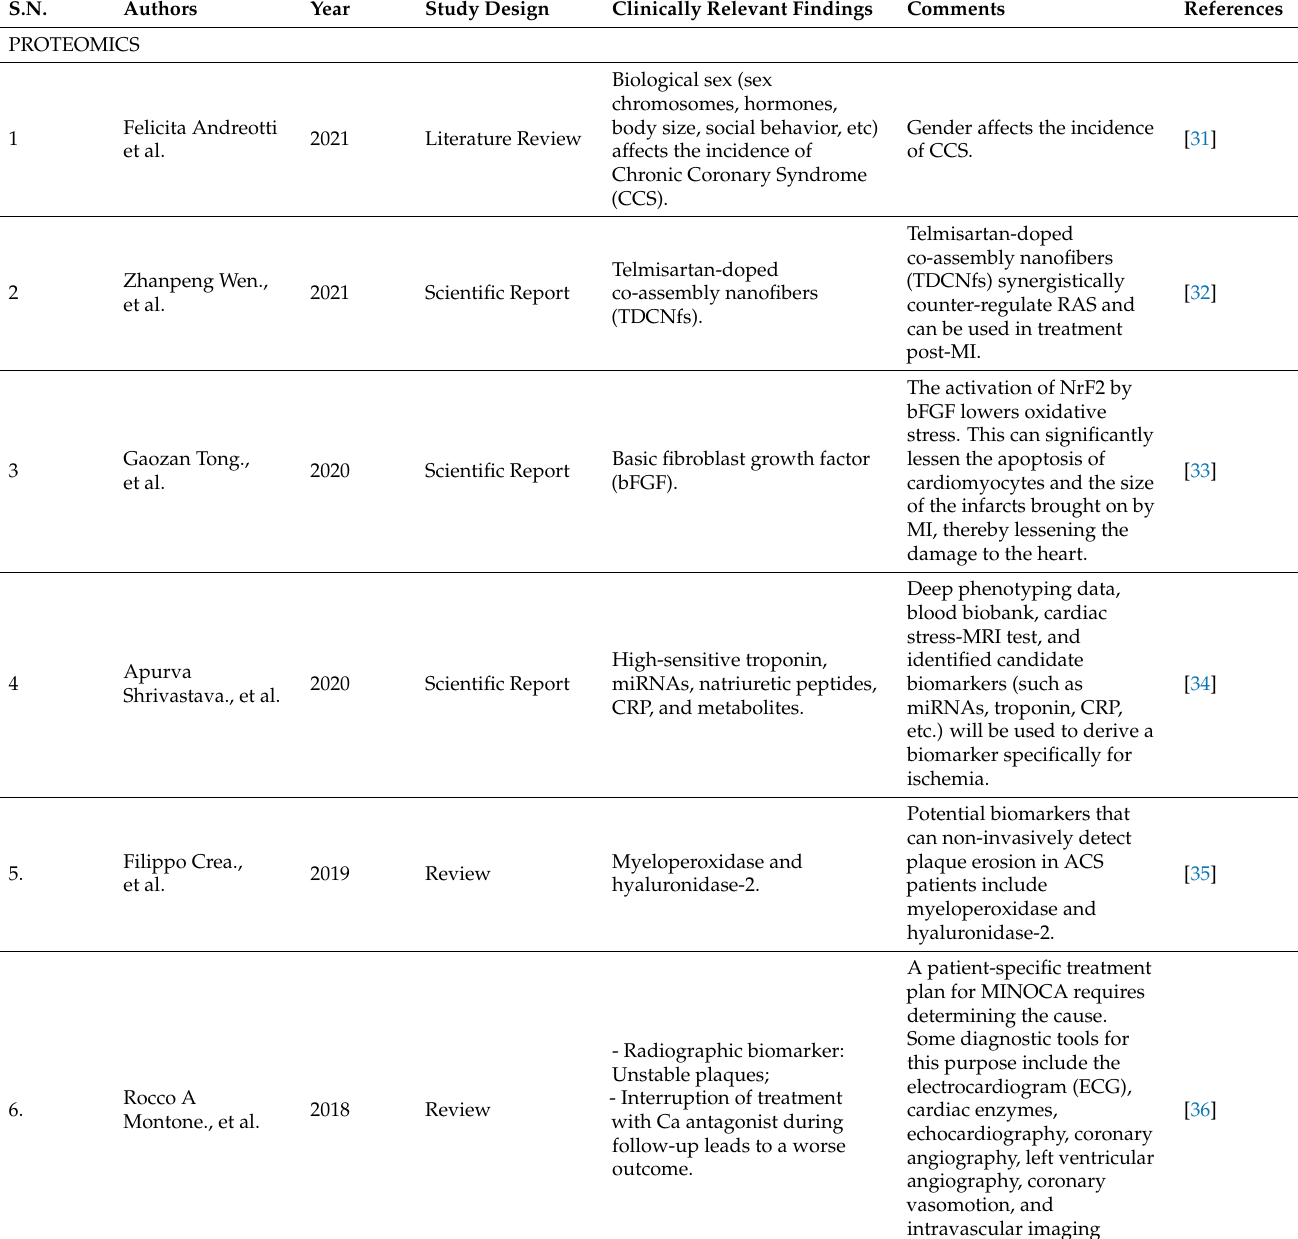
Table 2. A compilation of the literature underlining the role of precision medicine in myocardial